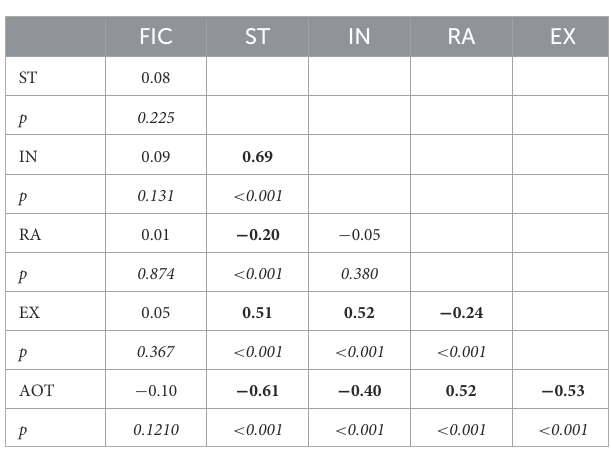
TABLE 6 Experiment 2: correlations between FIC and values of risk-style (stimulating and instrumental risk) and cognitive-style (rational thinking, experiential thinking, and actively open-minded thinking style).